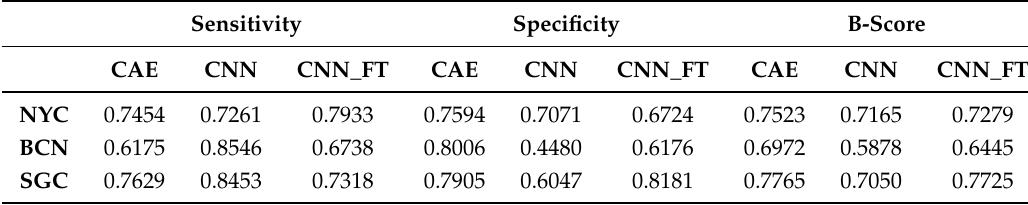
Table 1. Comparison of results using three different techniques for the image encoding step: using